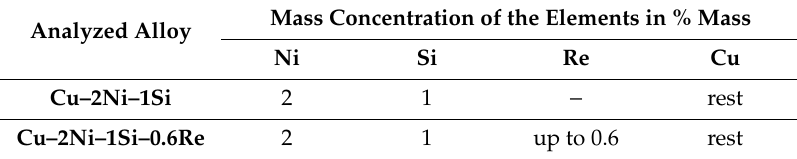
Table 1. Chemical composition of analyzed copper